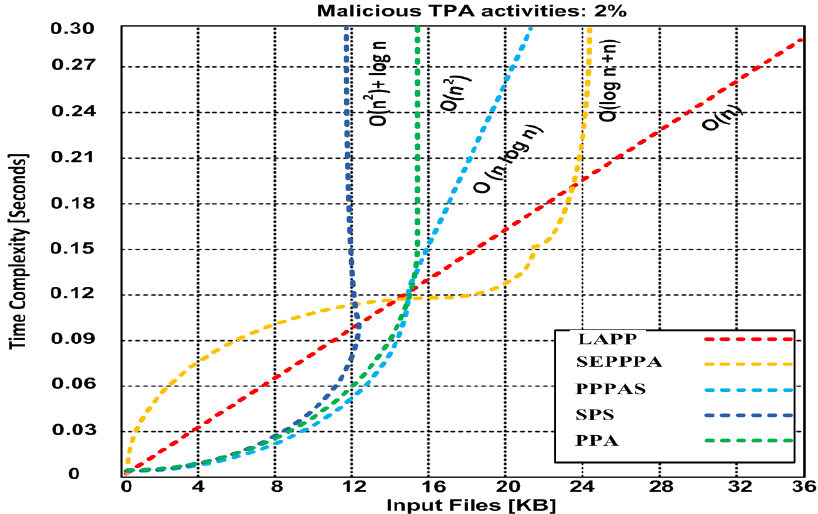
Figure 4. Time complexity (input files).